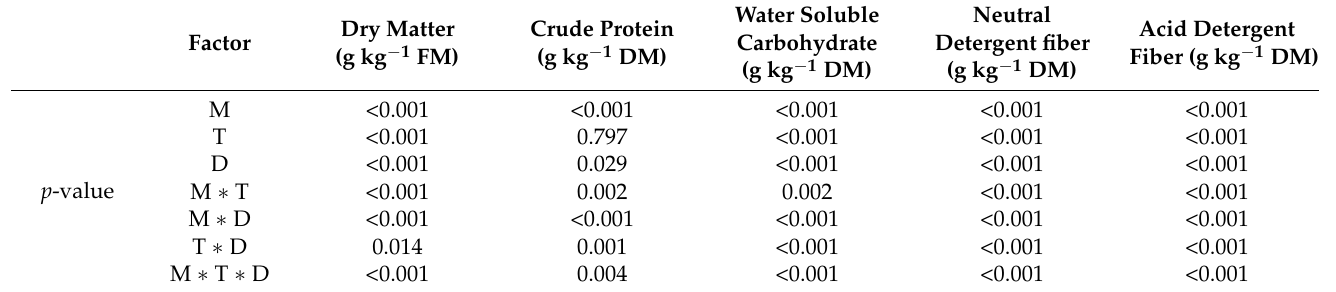
Table 7. Effect of different study factors and their interaction on chemical compositions of Stylosanthes silage.